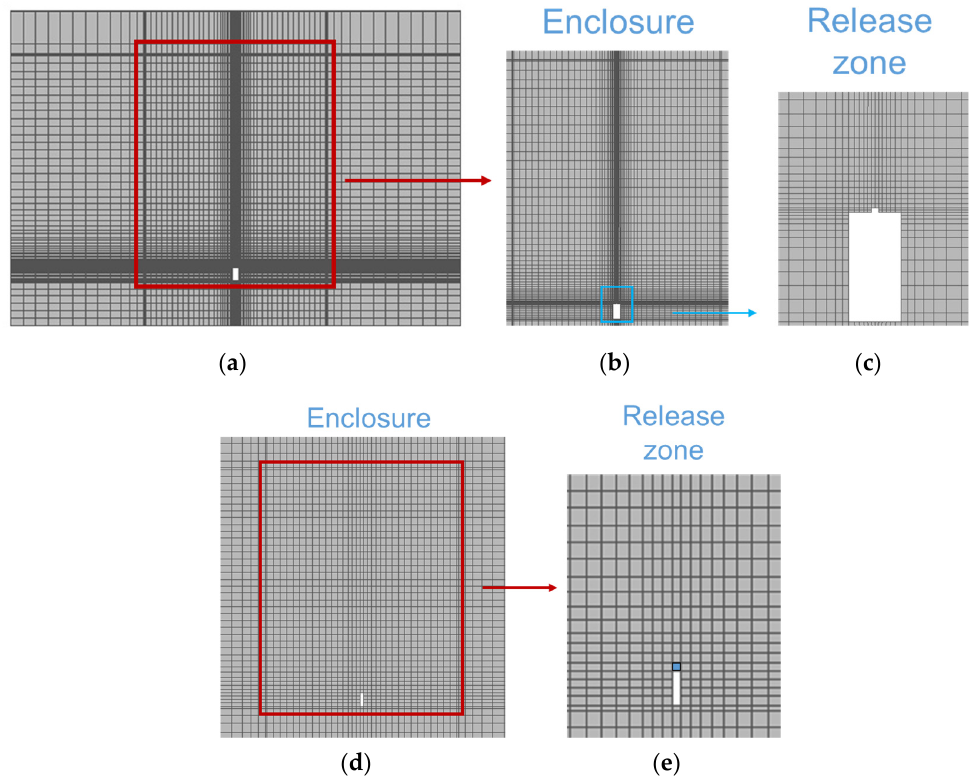
Figure 2. Cross-section of the calculation domain and numerical mesh: inflow boundary for notional nozzle exit approach—( a ) total calculation domain, ( b ) detail of the enclosure, ( c ) enlargement of the release zone; volumetric source (VS) approach—( d ) enclosure, ( e ) enlargement of the release zone with VS in light blue.